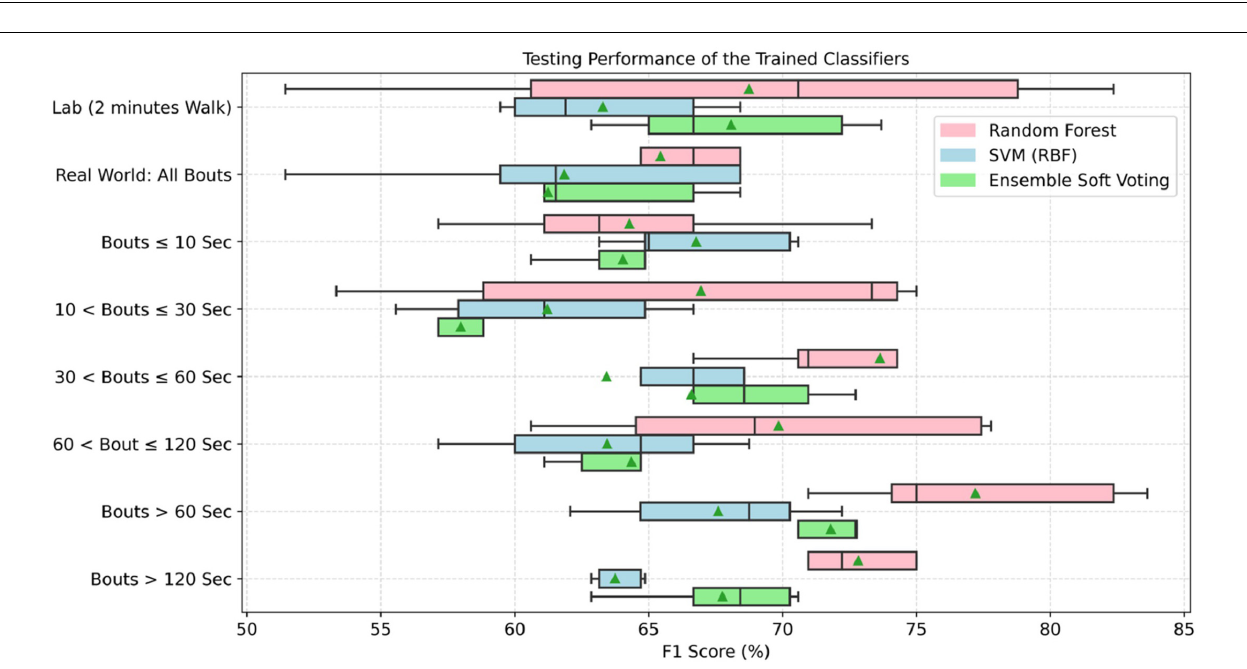
FIGURE 7 | Accuracy of trained classifiers based on the lab and real-world assessment of gait grouped by WB durations ( (cid:78) means average testing accuracy across all tests on independent dataset).